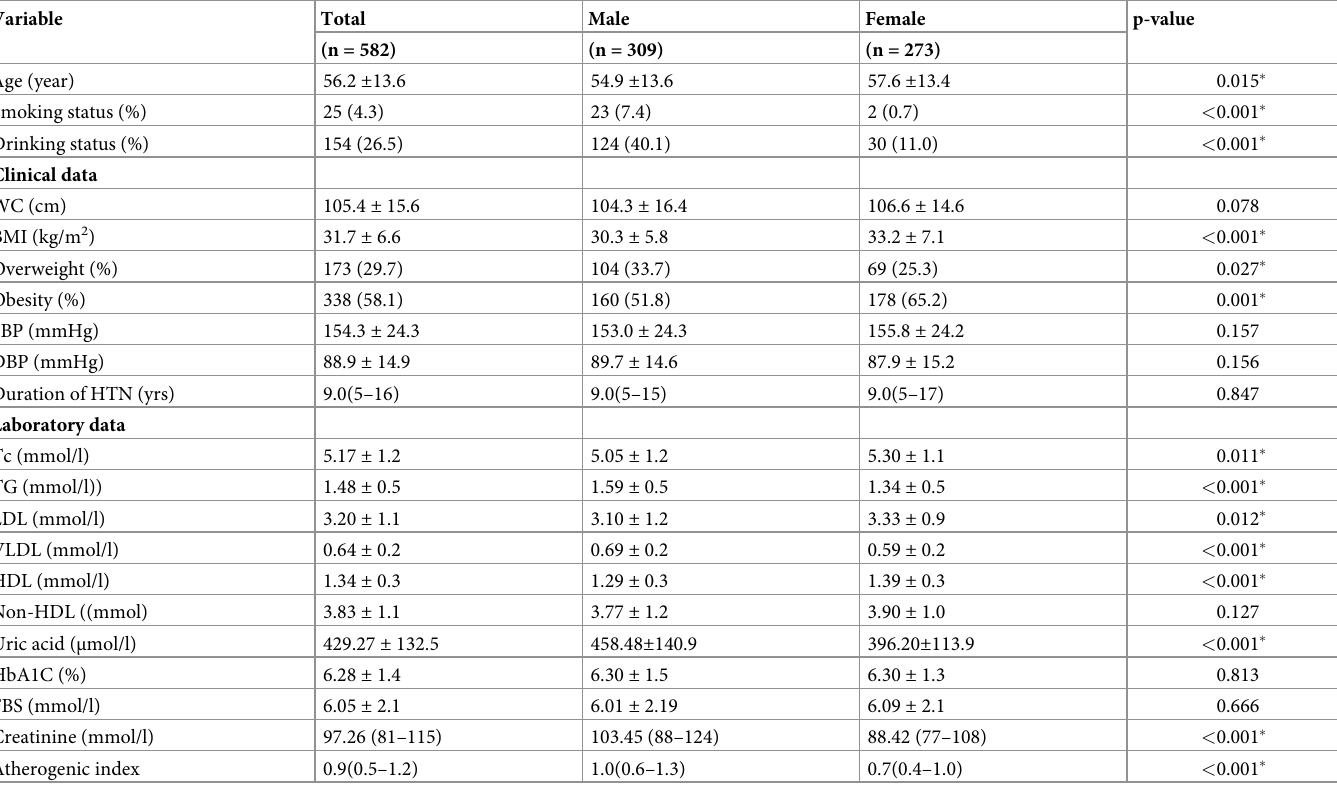
Table 1. General characteristics of the study